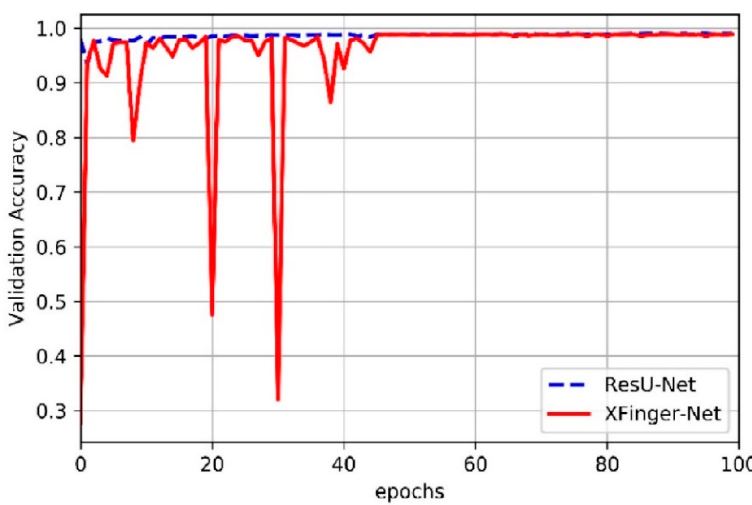
Figure 7. Train loss of XFinger-Net and ResU-net with epoch during training.